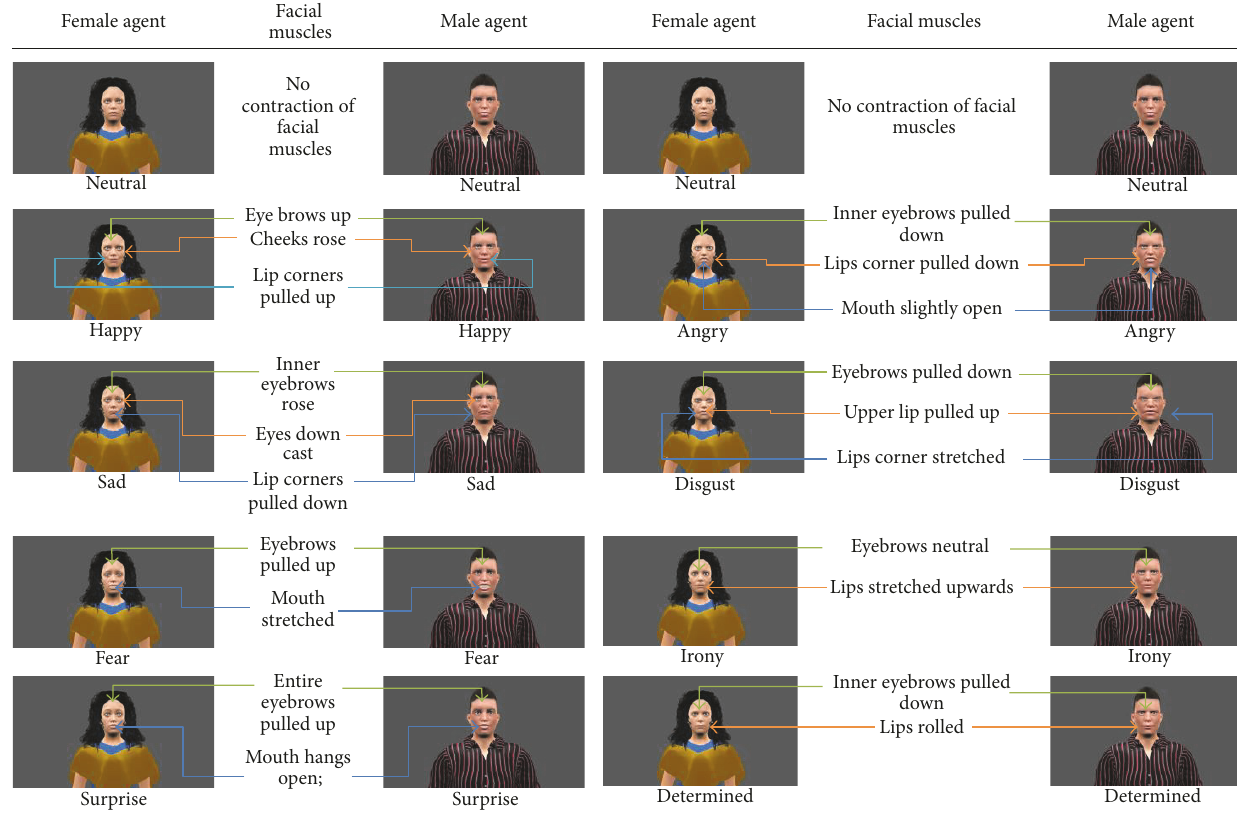
(a) Nodding : head is tilted in alternating up and down arcs along the sagittal plane. Nodding of head is used to indicate acceptance. (b) Shaking : head is turned left and right along the transverse plane repeatedly in a quick suc- cession. Shaking of head is used to indicate disagreement, denial, or rejection.